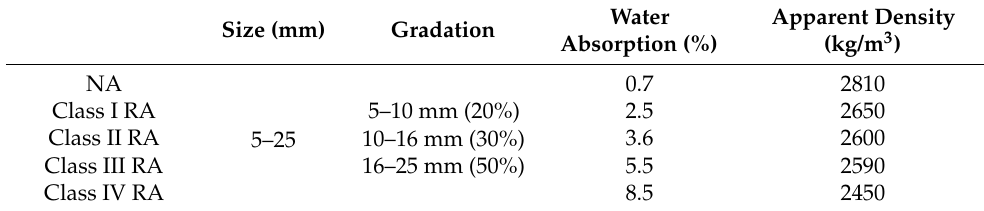
Table 4. Properties of coarse aggregate in the laboratory tests.